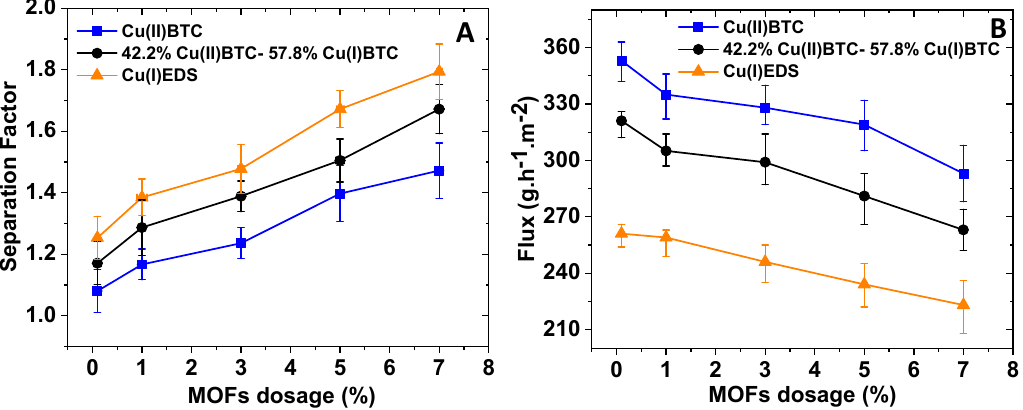
Figure 7. Separation factor ( A ) and flux ( B ) for mixed-matrix membranes (MMMs) with different percentages of Cu(II)BTC, Cu(II/I)BTC, and Cu(I)EDS for the separation of toluene and n-heptane from a feed mixture with 58 mol% of toluene.